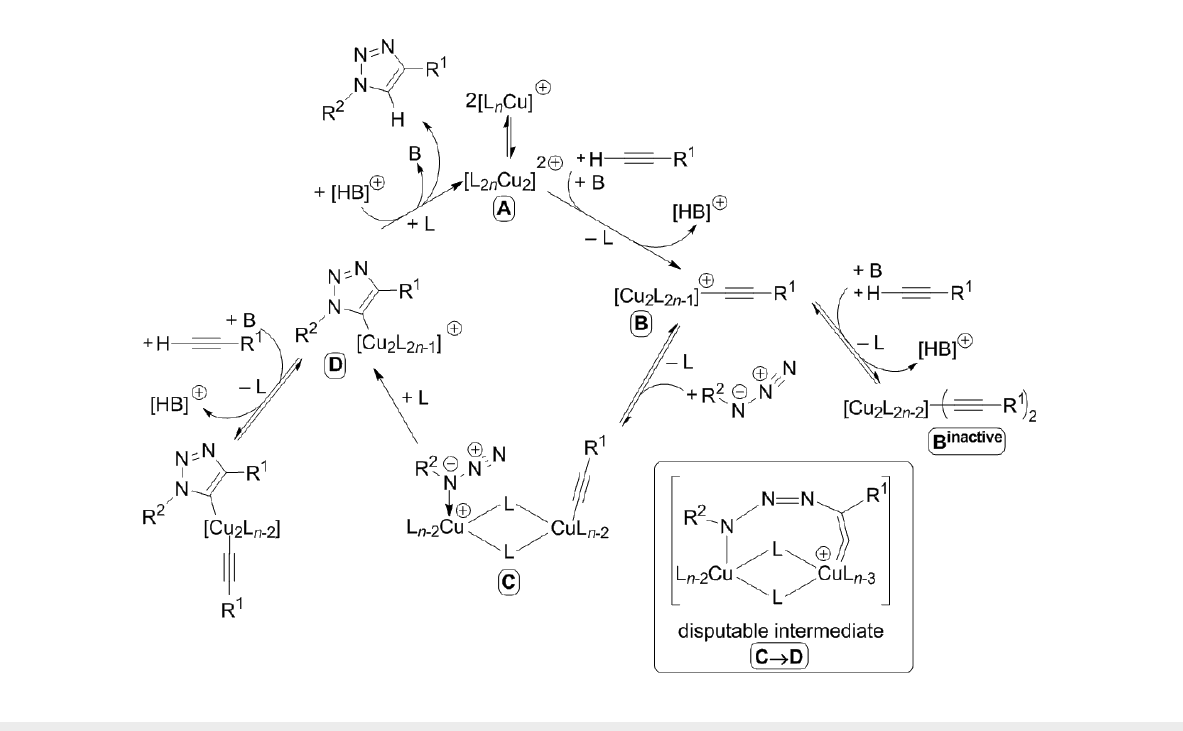
Scheme 18: Catalytic cycle of the CuAAC reaction on the basis of the proposed mechanistic scheme by Fokin and Finn in 2005 [160] and a disputable intermediate for the first C–N bond-forming step as formulated in a review article by van Maarseeven